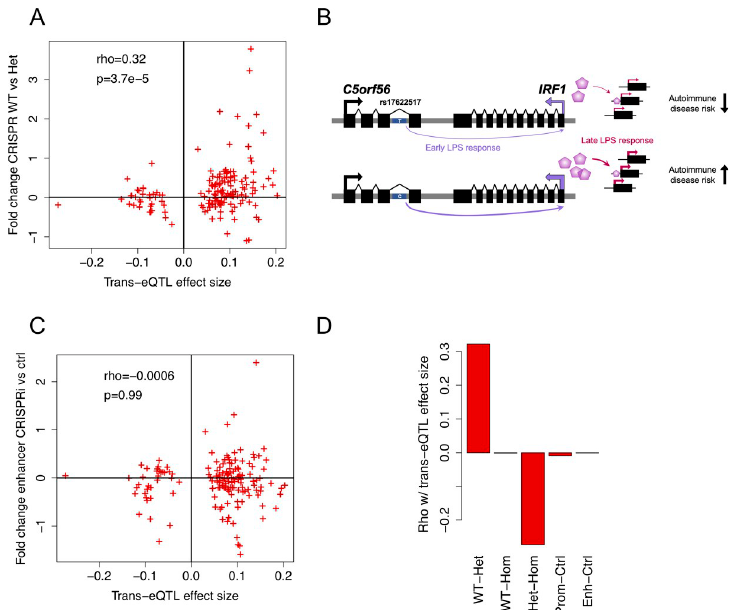
Fig 4. Trans-eQTL effects captured by experimental data. A) Correlation of trans-eQTL effect size with differential expression in CRISPR-edited heterozygous clones, B) Summary of the model supported by data of this study, with the rs17622517 C allele increasing the expression of IRF1 in cis under early immune stimulation, with downstream effects in trans under late immune stimulation. The C allele is also a risk allele for several autoimmune traits. C) Correlation of trans-eQTL effect size with differential expression after silencing of the enhancer locus with CRISPRi, and D) summarized for all the experimental comparisons.